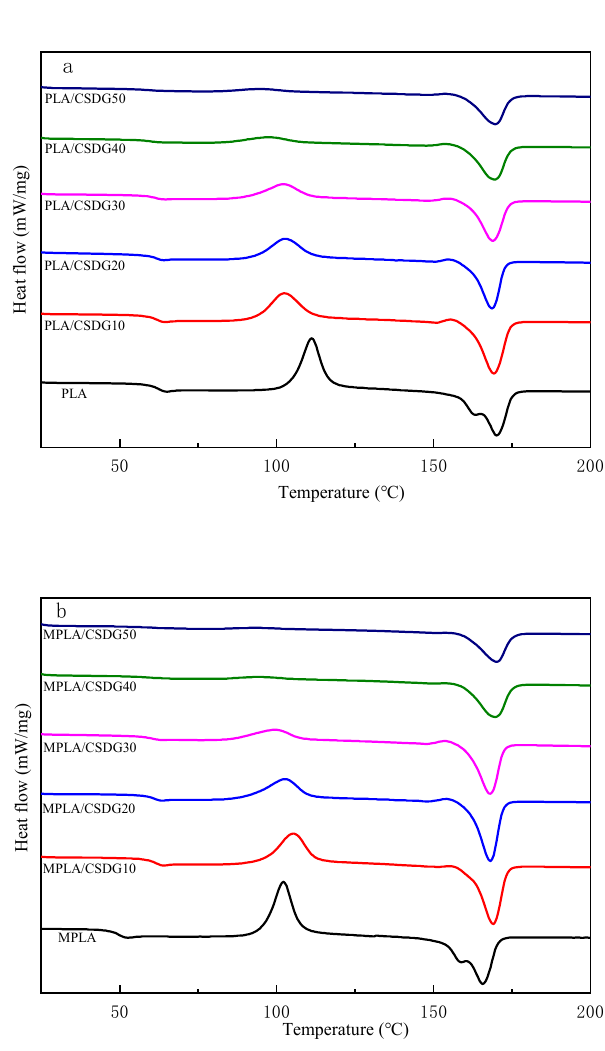
Figure 7. Second heating curves: ( a ) PLA/CSDG; ( b ) MPLA/CSDG. Table 3. Differential scanning calorimetry data for PLA, PLA/CSDG, MPLA, and MPLA/CSDG.